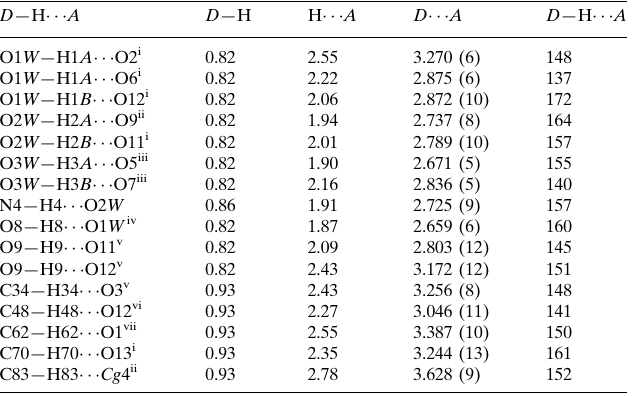
Hydrogen-bond geometry (A˚ , (cid:4) ). Cg 4 is the centroid of the C32–C37